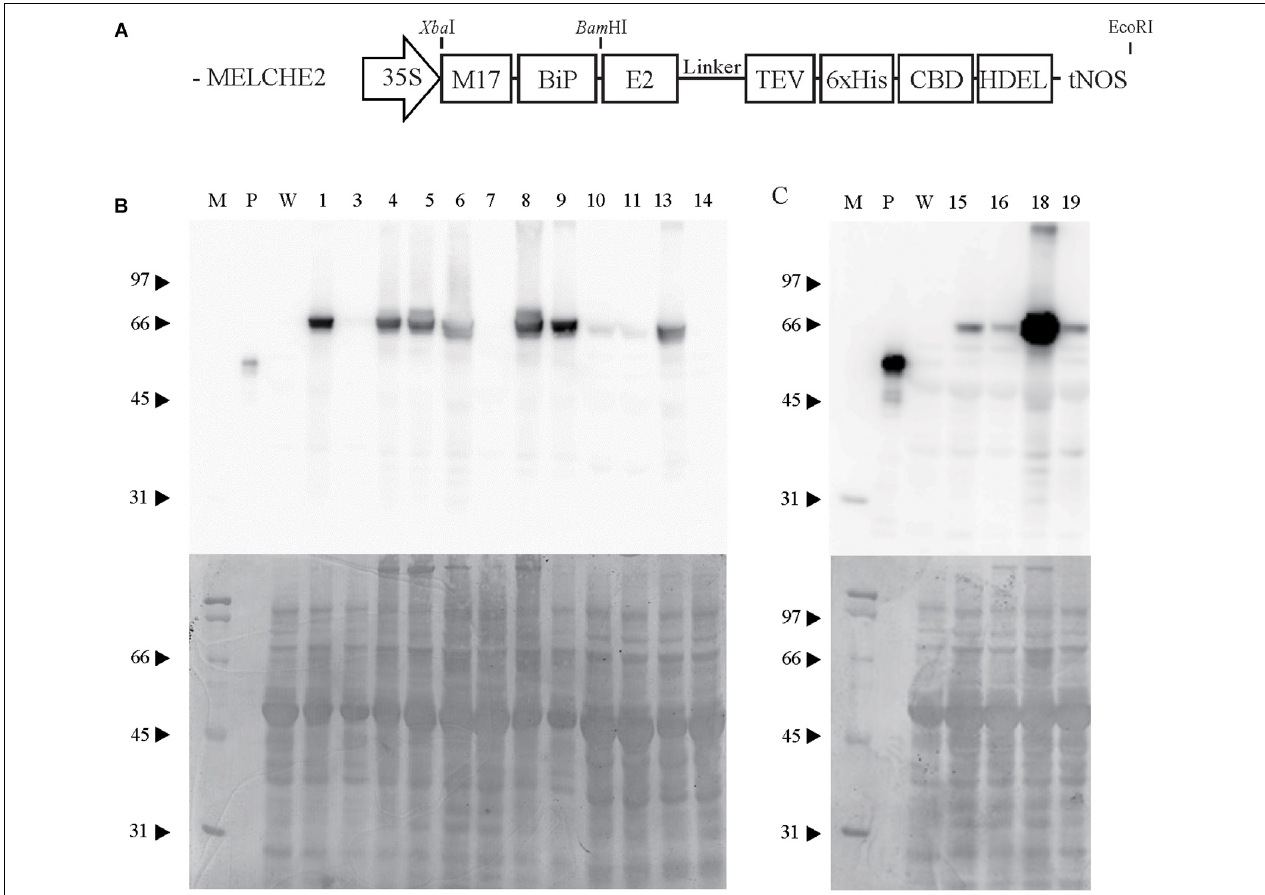
FIGURE 1 | Design of the MELCHE2 construct and selection of transgenic plants expressing recombinant E2 fusion protein at high levels. (A) Schematic view of the MELCHE2 construct. 35S, double cauliflower mosaic virus 35S promoter; M17, 5 (cid:48) untranslated region; BiP, endoplasmic reticulum (ER)-targeting signal peptide; E2, classical swine fever virus envelope glycoprotein E2; TEV, tobacco etch virus protease site; CBD, cellulose-binding domain of xynA; HDEL, ER-retention signal; tNOS, nos terminator. (B,C) Western-blot analysis of recombinant E2 fusion proteins expressed in T0 transgenic plants. Total protein was prepared from 16 independent lines at T0, and 50 µ g of each extract was subjected to western blotting using anti-CBD antibody. Blots were stained with Coomassie Brilliant Blue after immunoblotting, as shown in the lower panel. M, protein standards (molecular weights in kD shown to the left); P, CBD positive control (GFP:CBD 10 ng); W, wild-type Nicotiana benthamiana used as a negative